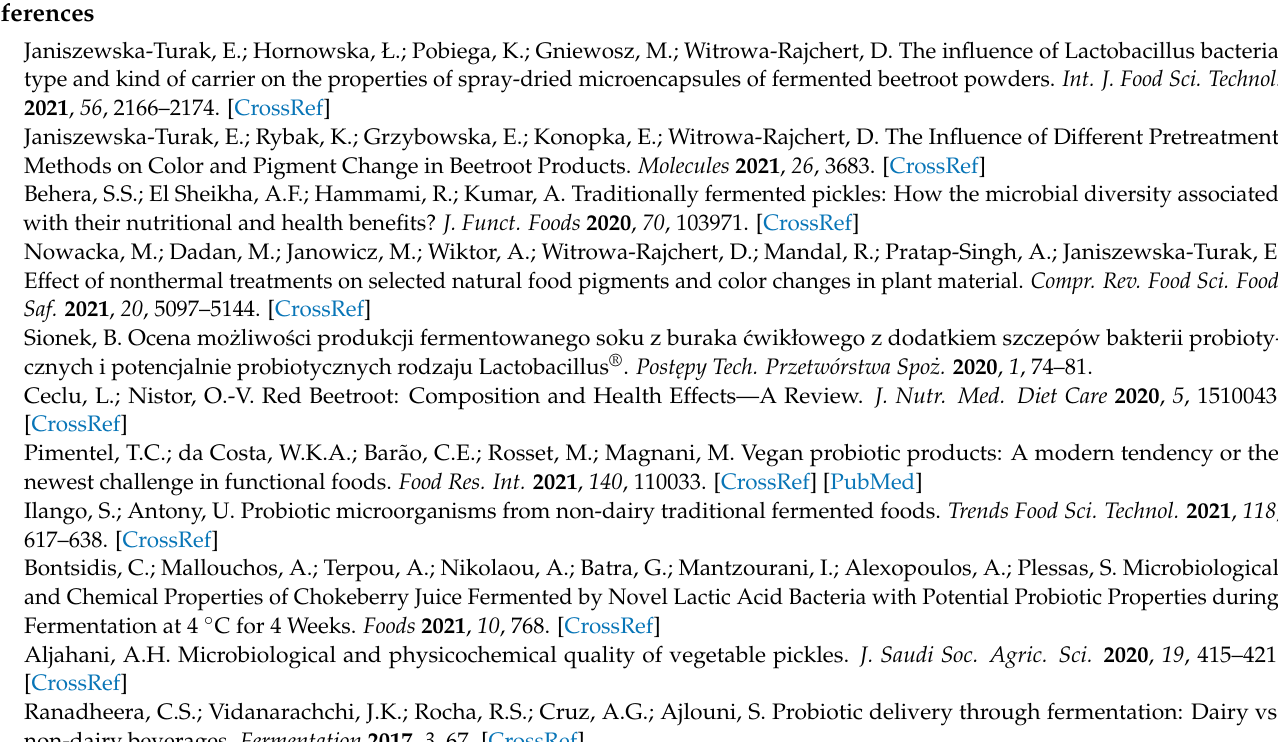
Supplementary Materials: Table S1. Pre-tests results for juices; Figure S1: Photo of: (a) beetroot juice and fermented beetroot juice without and with carrier (Maltodextrin -MD); (b) obtained powders Figure S2: Sorption kinetics for powders Figure S3: Derivative curves of TGA analysis for